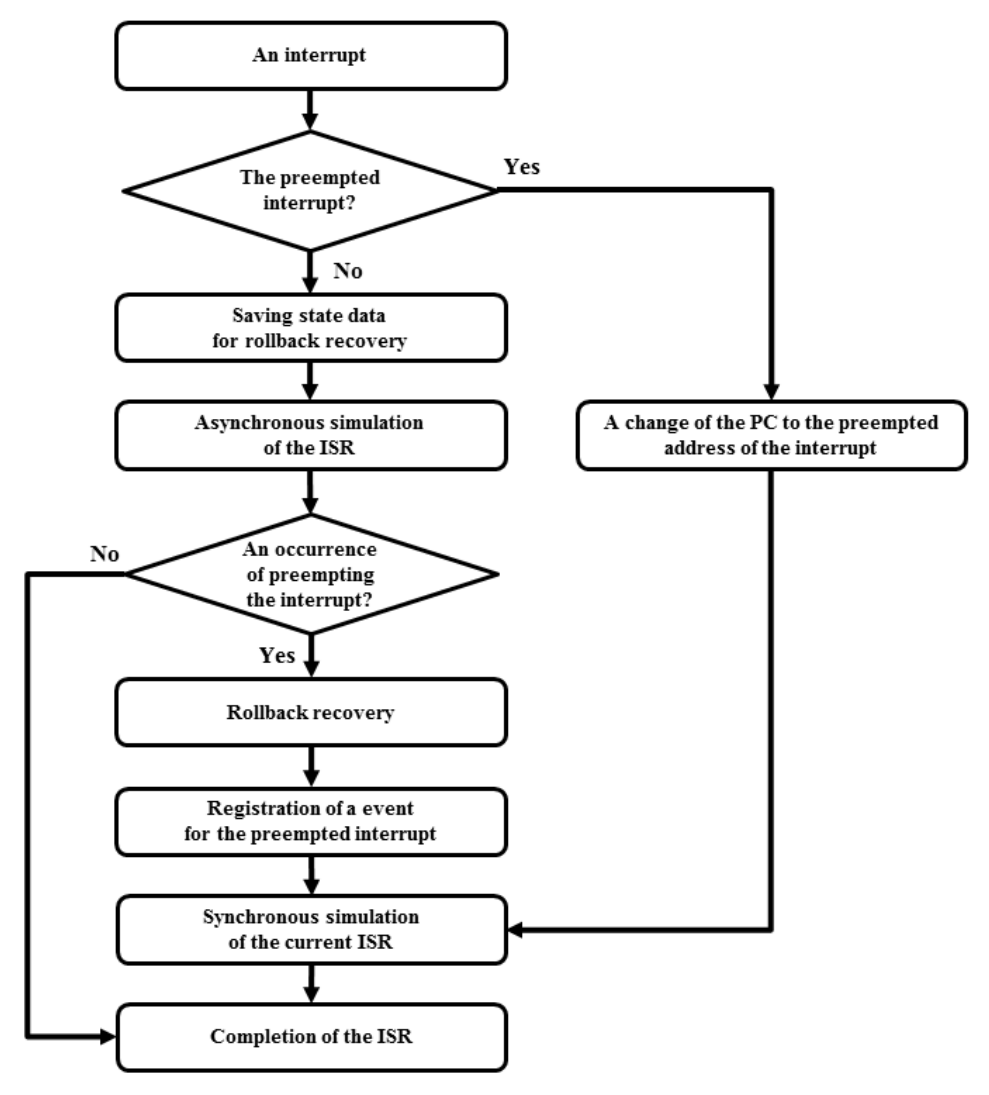
Figure 2. Asynchronous simulation of